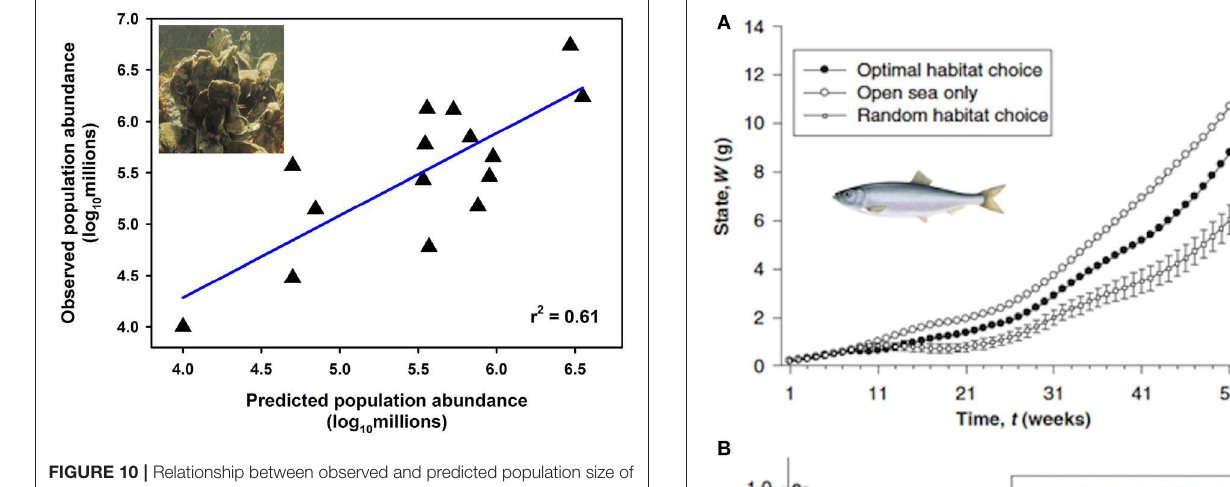
FIGURE 10 | Relationship between observed and predicted population size of oysters using a metapopulation model at natural subtidal and restored reefs of eastern oyster Crassostrea virginica . Estimates of observed population size were derived from field sampling of natural subtidal and restored reefs during 2012; estimates of predicted population size were derived from metapopulation model simulations corresponding to the same time period (assuming a larval mortality rate of 10% day − 1 ). Linear least-squares regression of log 10 -transformed data ( p < 0.001). Figure adapted with permission (S. Theuerkauf, copyright holder) from Theuerkauf (2017). Oyster figure derived from http://cbf.typepad.com/chesapeake_bay_foundation/ 2015/04/restoring-the-coral-reefs-of-the-chesapeake.html.